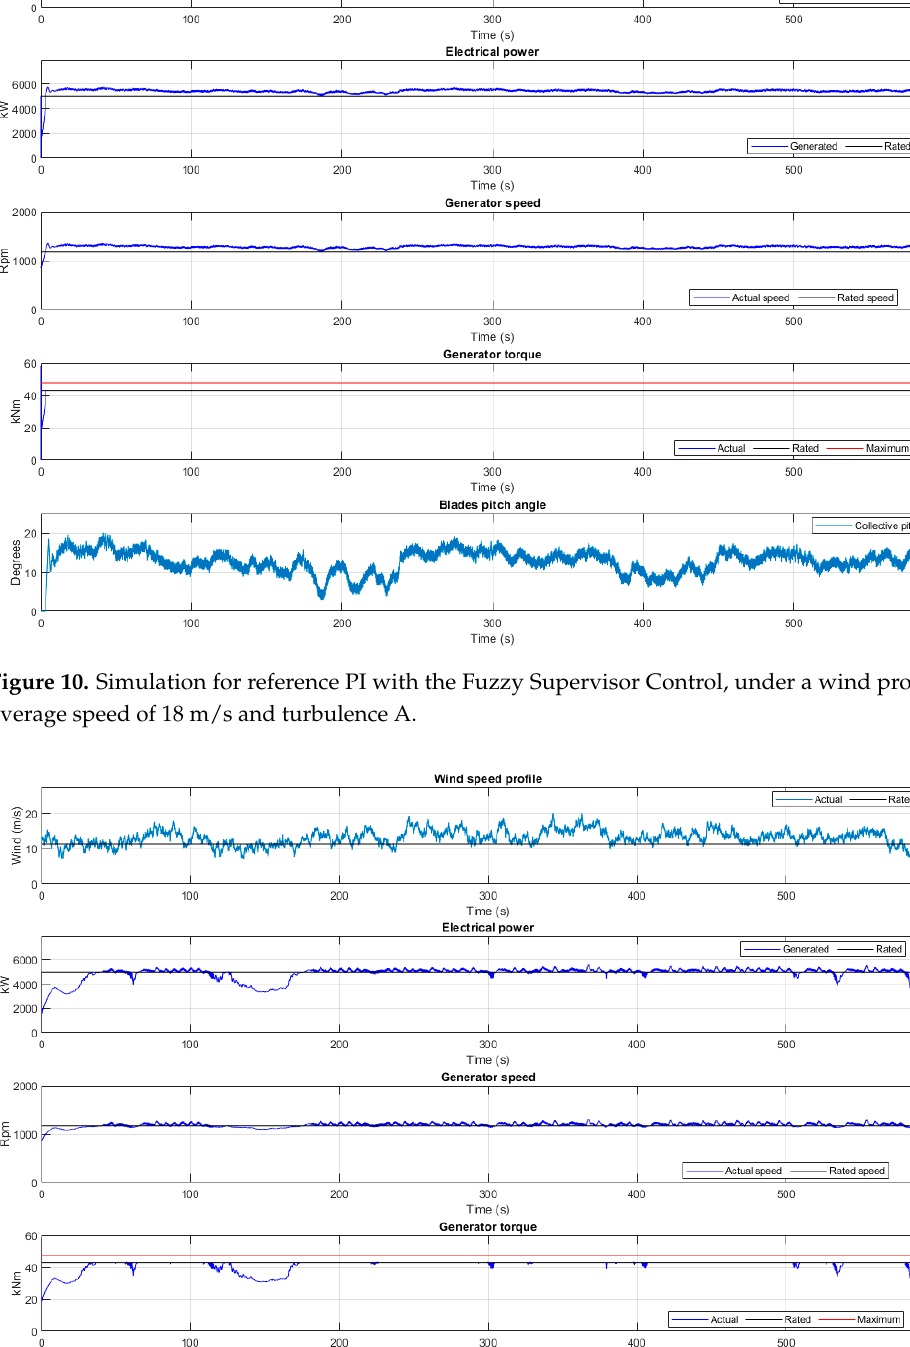
Figure 9. Simulation for reference PI with the Fuzzy Supervisor Control, under a wind profile of average speed of 15 m/s and turbulence A.